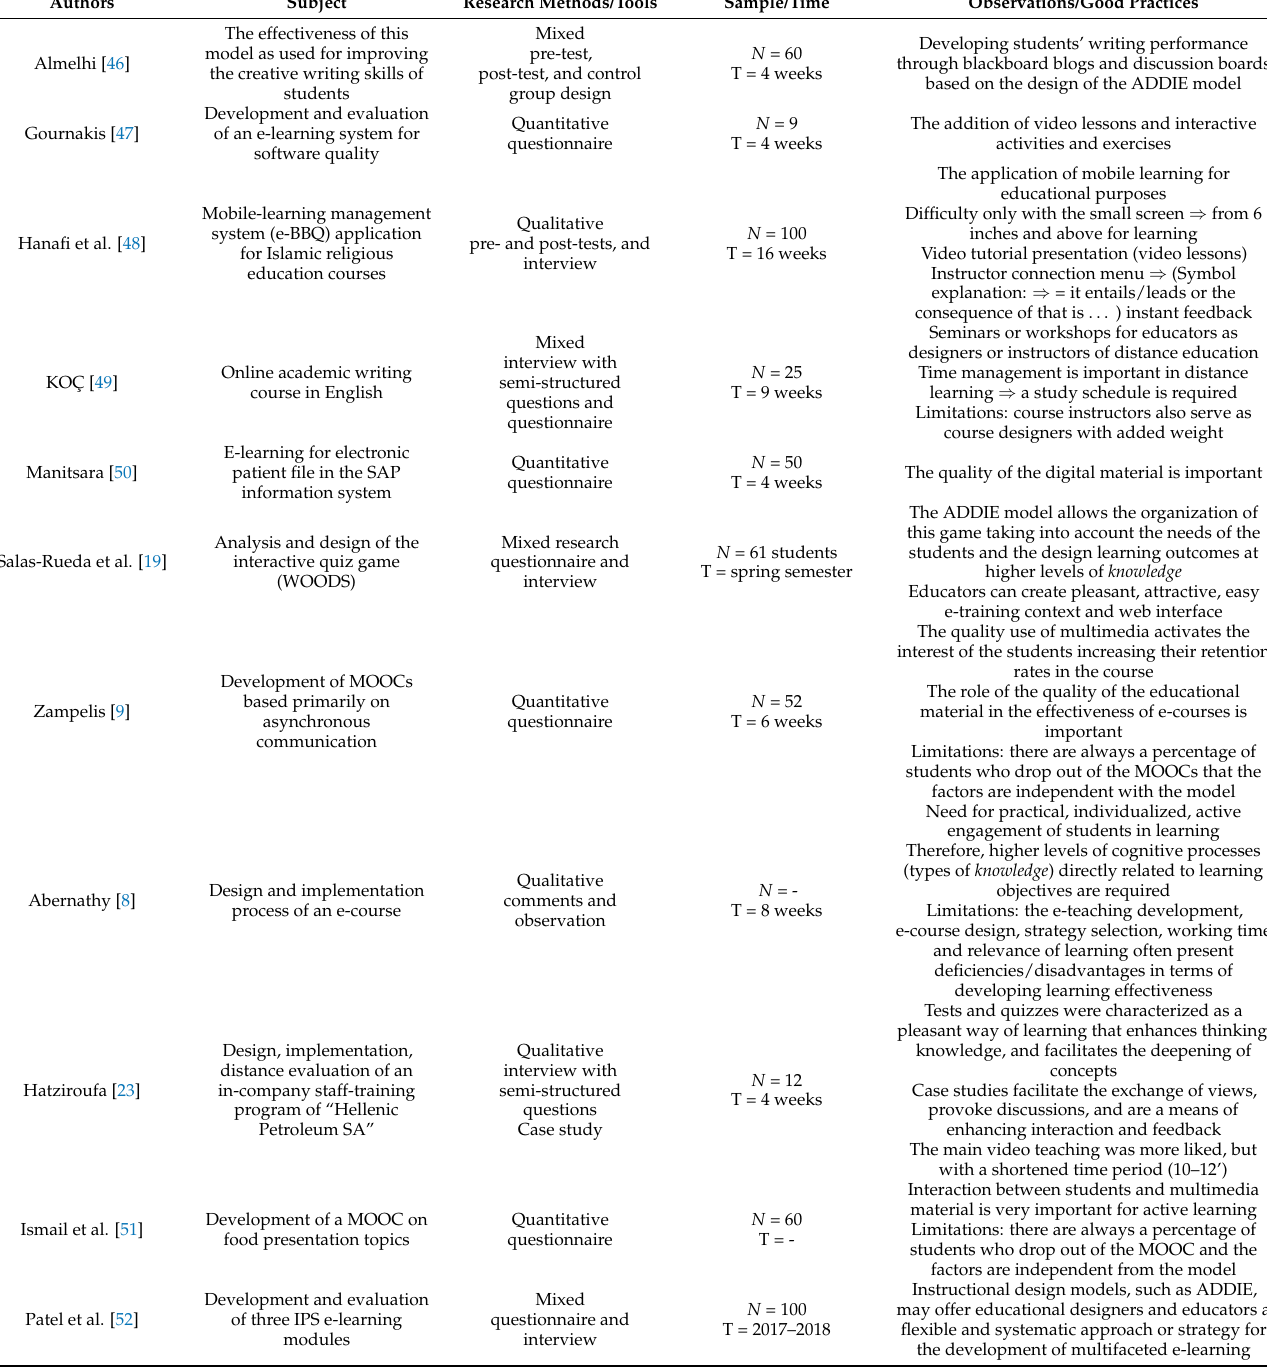
Table 2. The main characteristics of the relevant articles for the ADDIE